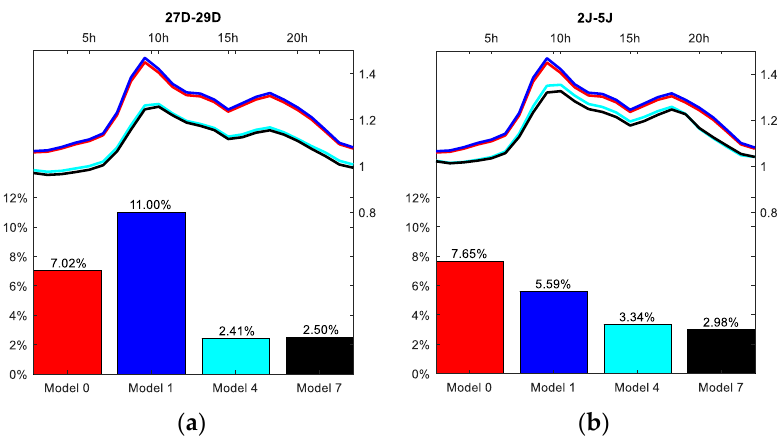
Figure 16. ( a ) Coefficient profile and MAPE for models 0, 1, 4, and 7 for the Christmas period 27 – 29 Dec. ( b ) Coefficient profile and MAPE for models 0, 1, 4, and 7 for the Christmas period 2 – 5 Jan.